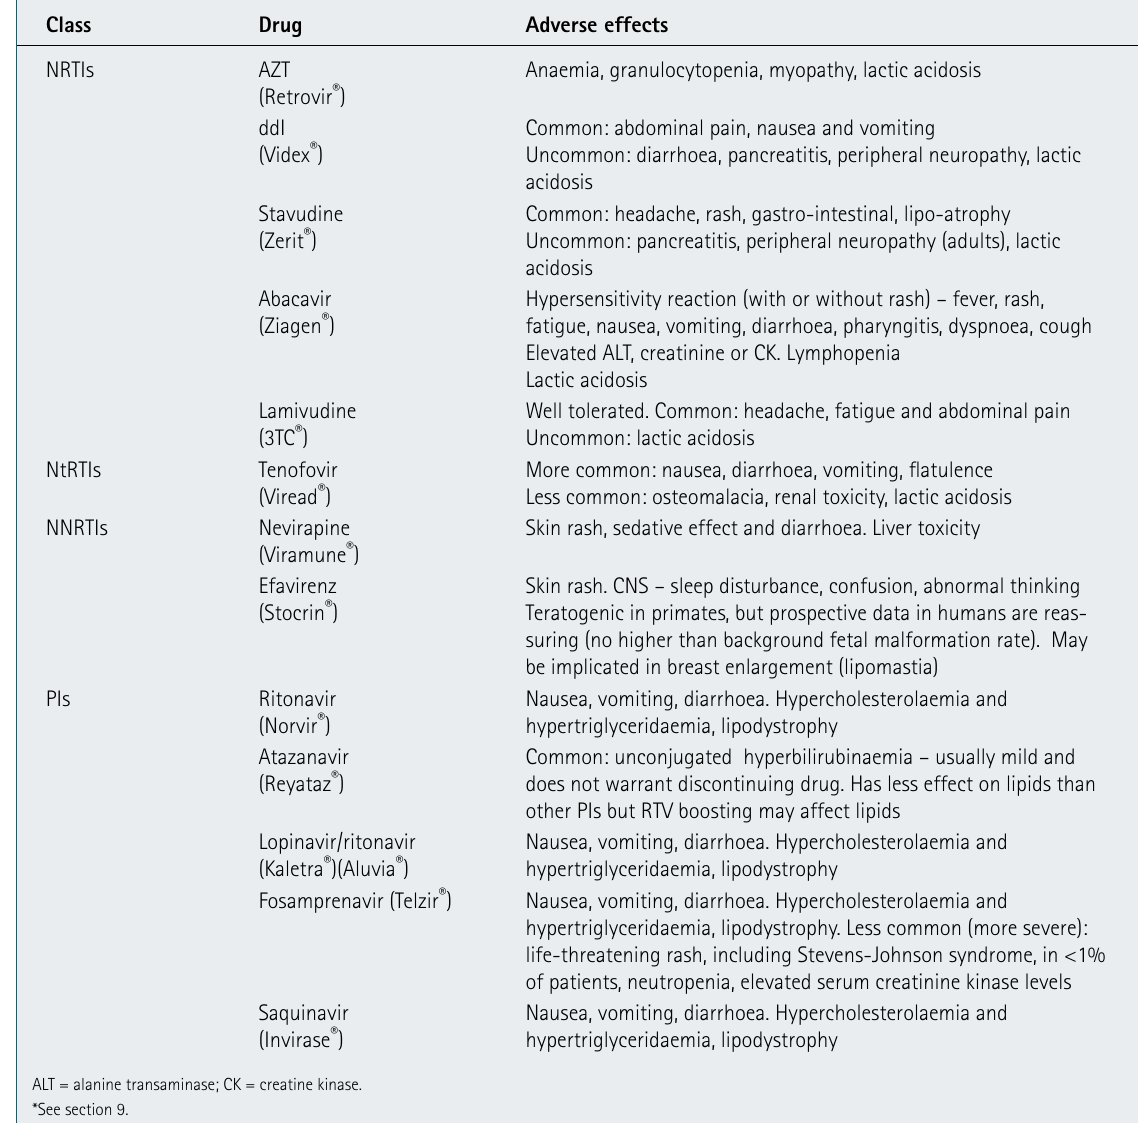
TABLE VI. ADVERSE EFFECTS OF ARVs IN